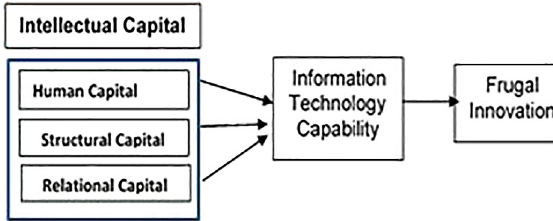
Figure 9. Theoretical